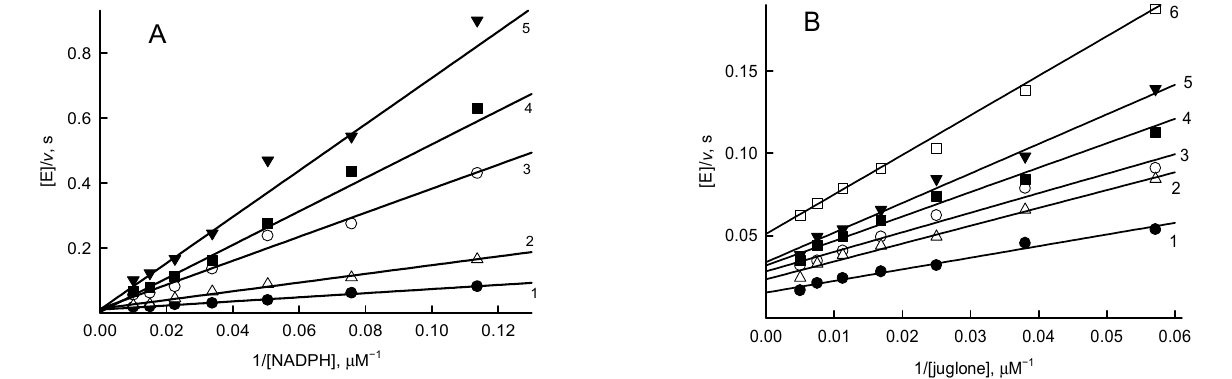
Figure 5. Inhibition of Rp FNR-catalyzed reactions by NADP + . ( A ) Competitive inhibition of the juglone reductase reaction of Rp FNR by NADP + at varied concentration of NADPH and in the presence of 200 µM juglone. NADP + concentrations are 0 (1), 0.25 mM (2), 0.5 mM (3), 0.75 mM (4), and 1.0 mM (5). ( B ) Noncompetitive inhibition at varied juglone concentration in the presence of 100 µM NADPH. NADP + concentrations are 0 (1), 0.5 mM (2), 1.0 mM (3), 1.5 mM (4), 2.0 mM (5), and 3.0 mM (6).